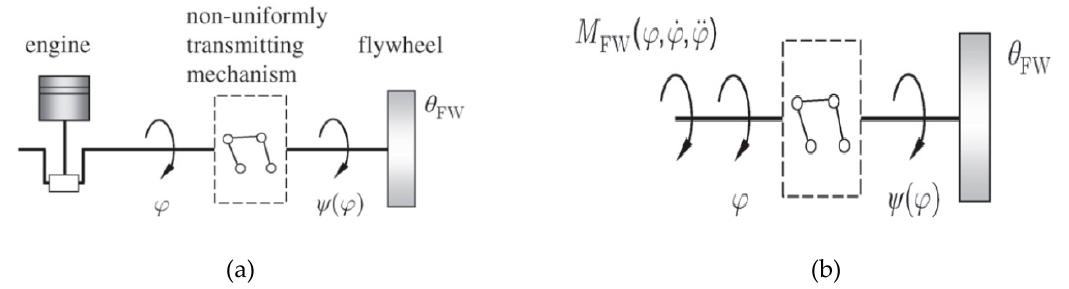
Figure 9. Kinematically driven flywheel (KDF) of a combustion engine: ( a ) schematic of the arrangement; ( b ) free-cut compensation system [27]. Figures are reprinted with permission from publisher.